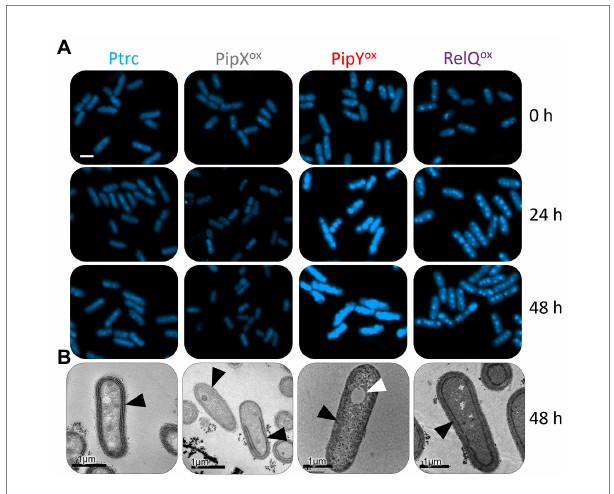
FIGURE 5 PipY ox induces giant polyP granules. (A) Confocal micrographs showing DAPI-polyP staining and (B) thin-section transmission electron microscopy images of cells growing with IPTG for the indicated number of hours. White scale bar, 2 μ m. Black arrowheads point toward the thylakoid membranes and white arrowheads to the atypical granular structures. Other details as in Figure